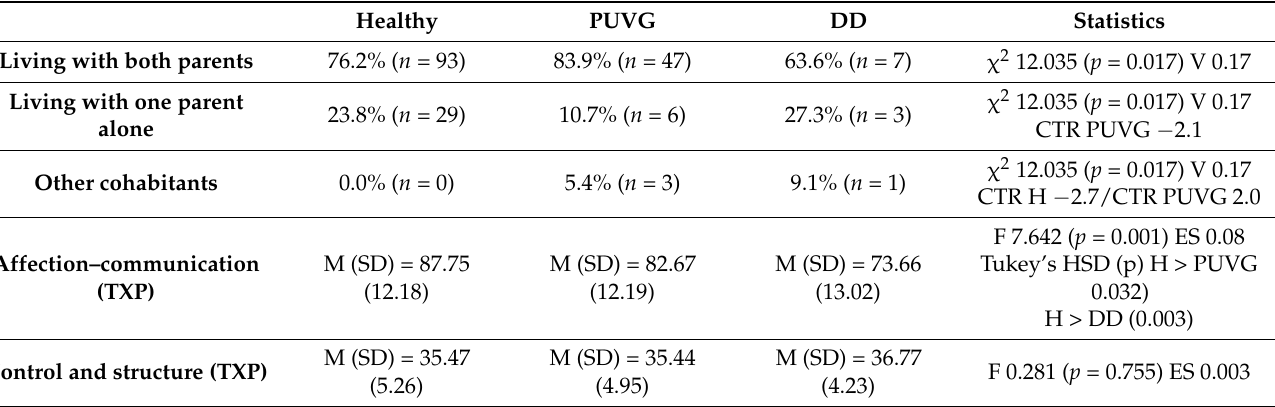
Table 3. The family dynamics of the adolescents included in the study ( N =